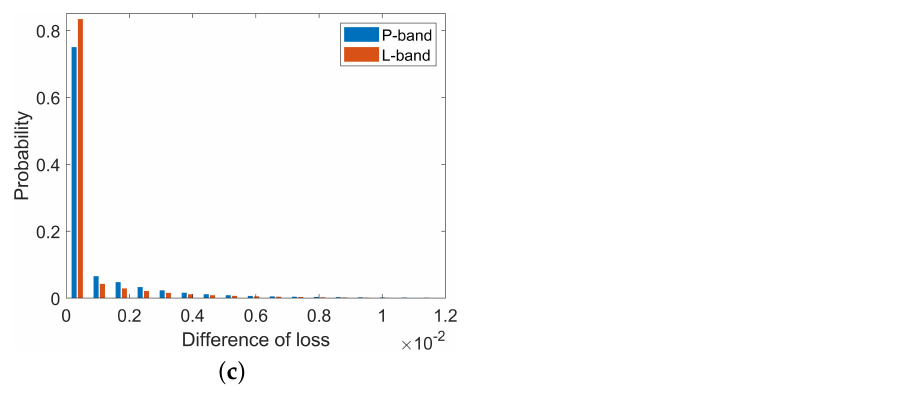
Figure 15. The absoulte difference of loss function between TSIA + IEBCR + ILUT and TSIA + IEBCR + LUT. ( a ) P-band. ( b ). L-band. ( c ). The distribution of the absoulte